Question: What visual encoding does this figure use to show its data?
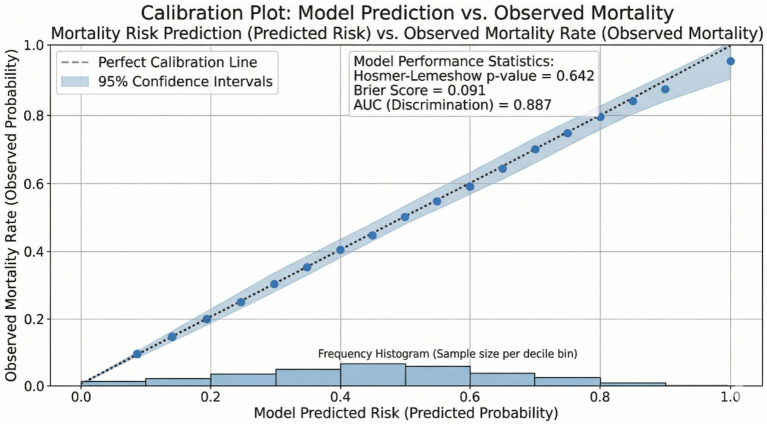
Answer: line